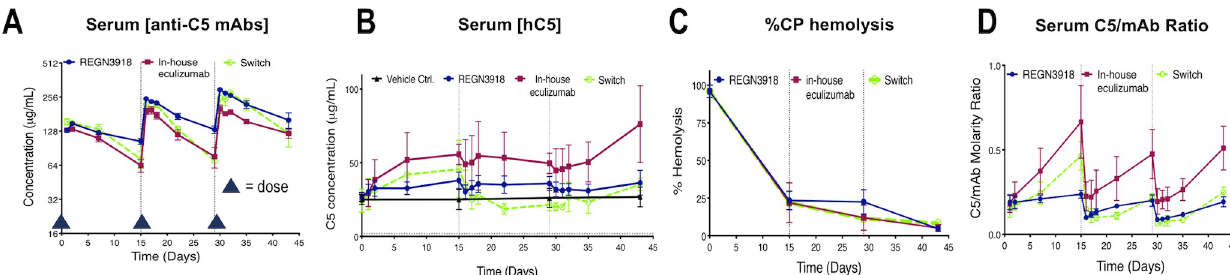
Fig 4. Dose switching from in-house eculizumab to REGN3918 results in normalization of serum C5 concentrations and maintained suppression of hemolytic activity. (A) Total hIgG concentration was measured by Gyros in serum collected from C5 hu/hu mice administered 3 doses of REGN3918 alone (blue), 3 doses of in-house eculizumab alone (red), or 1 dose of in-house eculizumab followed by 2 doses of REGN3918 (switch, green) ( � 14 mice/group). Arrowheads on y-axis and vertical grey dashed lines indicate times of dosing. (B) Total C5 serum concentrations in C5 hu/hu mice administered REGN3918 alone (blue), in-house eculizumab alone (red), or switched from in-house eculizumab to REGN3918 (switch, green) were measured from mice bled over the duration of the study. (C) Serum collected from terminally bled C5 hu/hu mice administered with REGN3918 alone (blue), in-house eculizumab alone (red), or in-house eculizumab/REGN3918 switched (green) were supplemented with hC3 and the percent of CP-mediated hemolysis using ex vivo assays was assessed. (D) Serum concentrations of total C5 and hIgG were used to calculate the ratio of C5:mAb at the indicated times. Data is plotted as mean ± SEM.